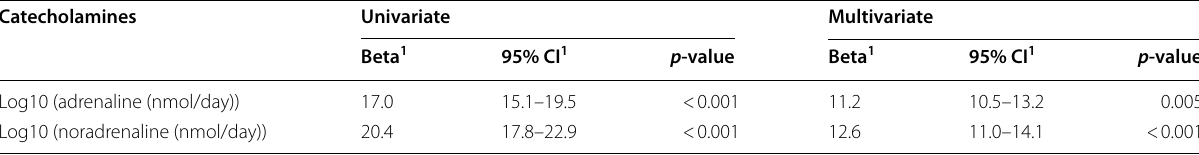
1 Beta increase in length of ICU stay (days) with one unit increase of the urinary catecholamine excretion measured (nmol/day) on a log base 10 scale, CI confidence = interval Multivariate analyses: adjusted for age, sex, intrathecal and intramuscular treatment interventions, and total dose of medications (benzodiazepines, pipecuronium) during the first 5